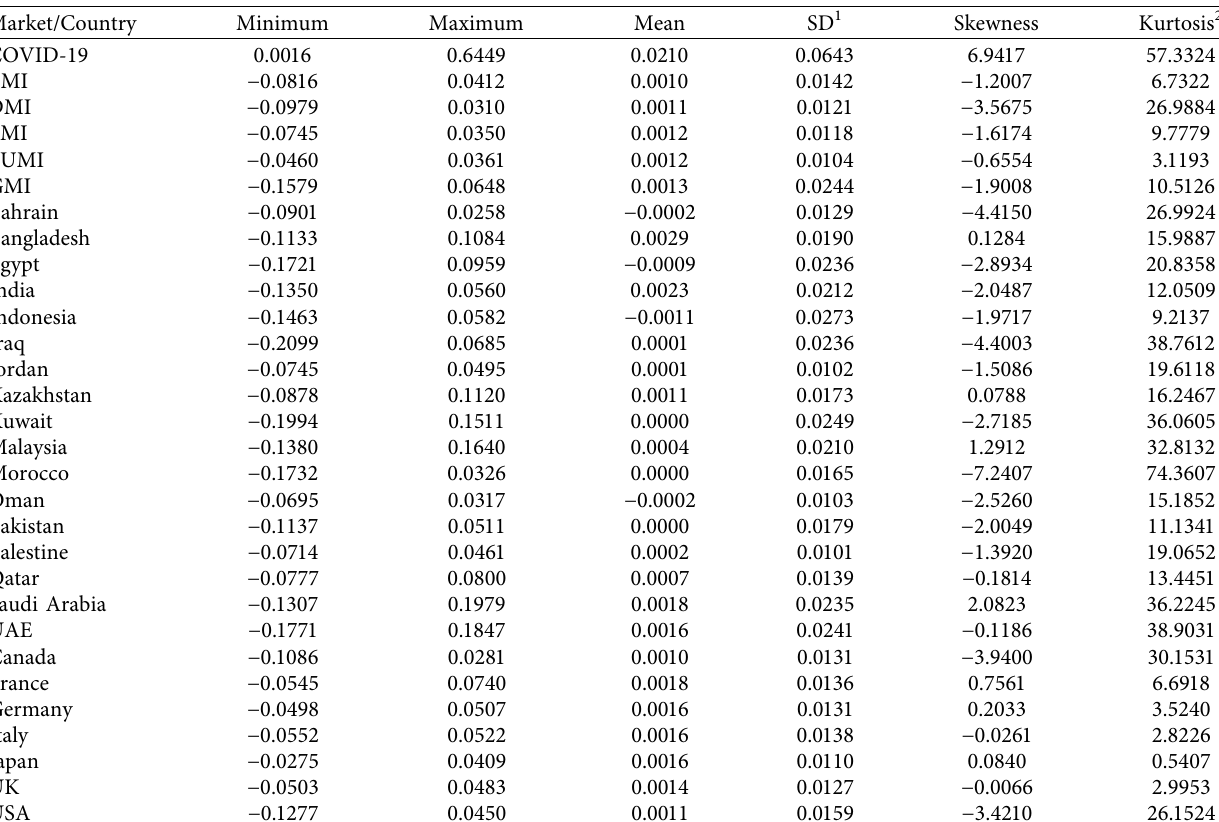
Figure 2: Time-series plot of selected equities and worldwide daily COVID-19 cases. Table 1: Descriptive summary of selected equities and worldwide daily COVID-19